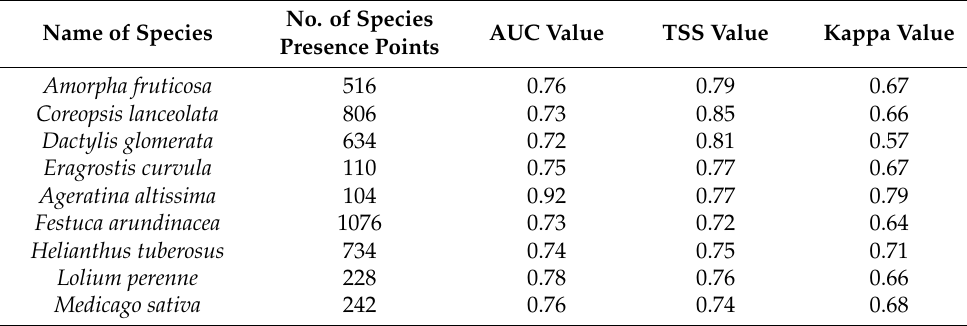
Table 3. AUC, TSS, and kappa values for each IIAPS in the model calibration.